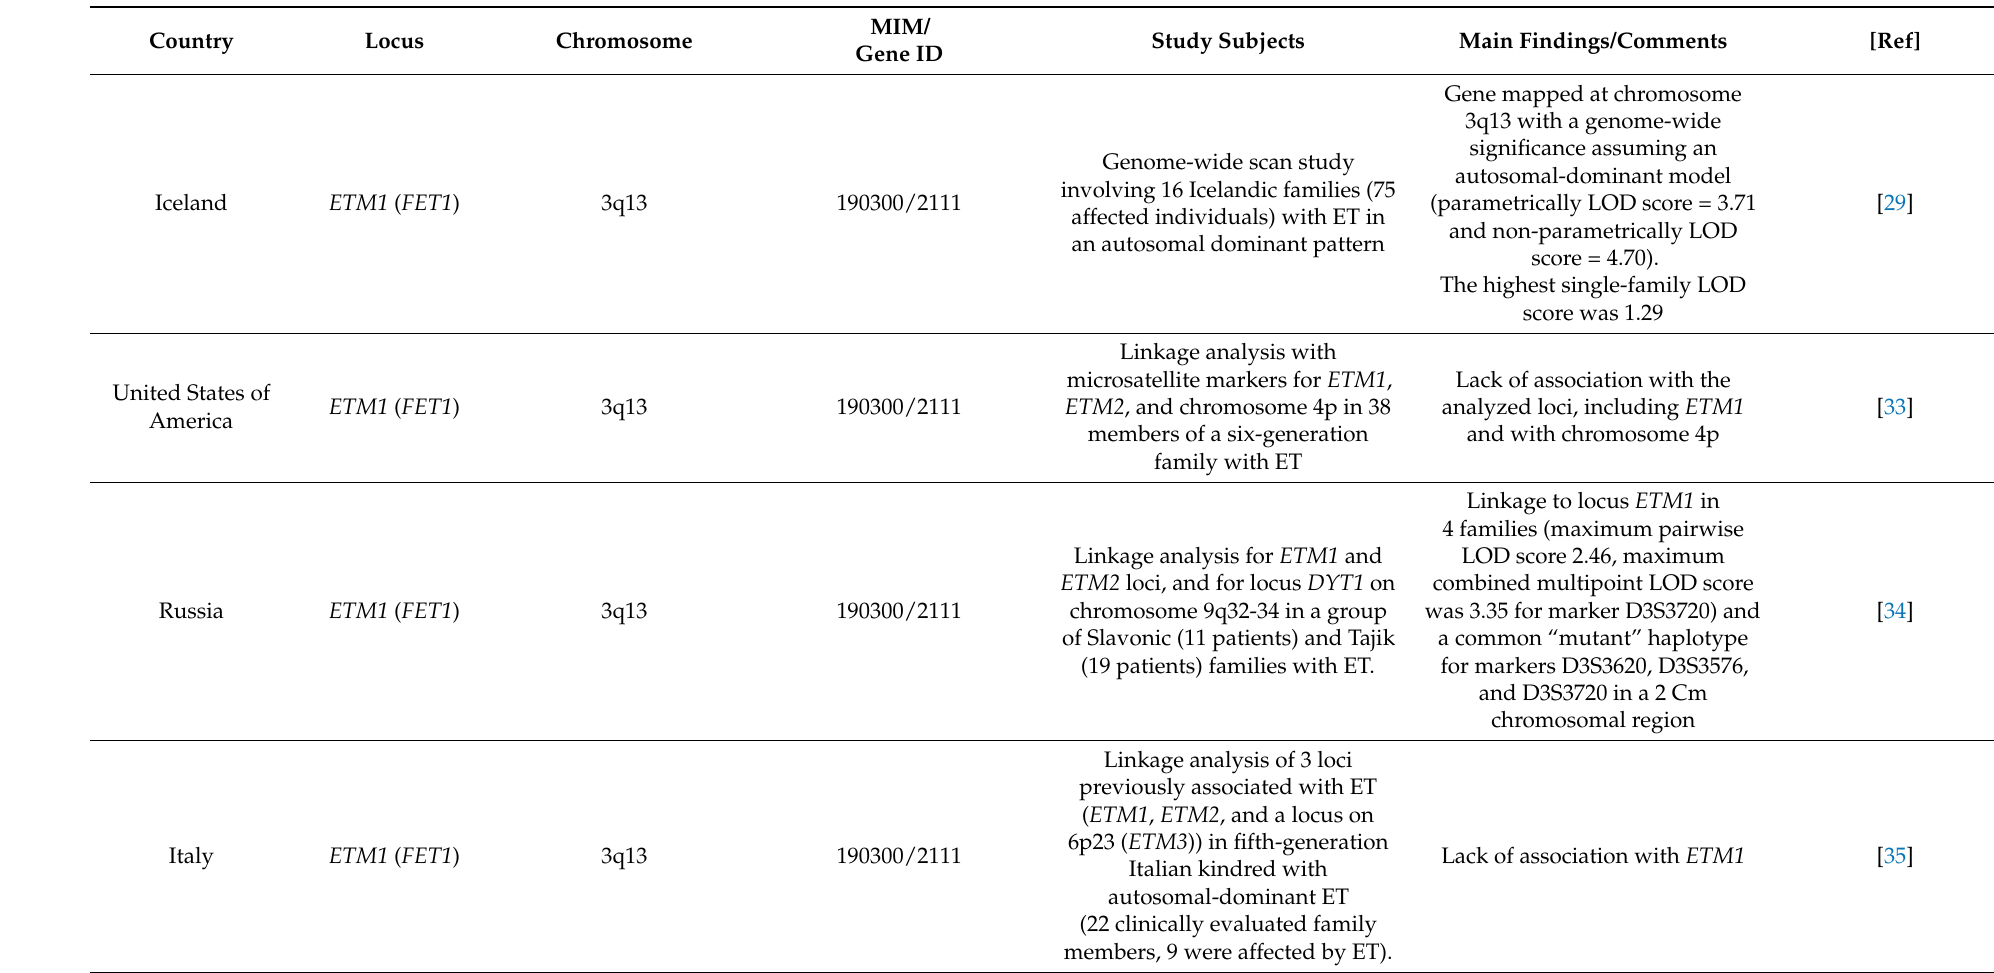
Table 1. Results of linkage studies in patients with familial essential tremor